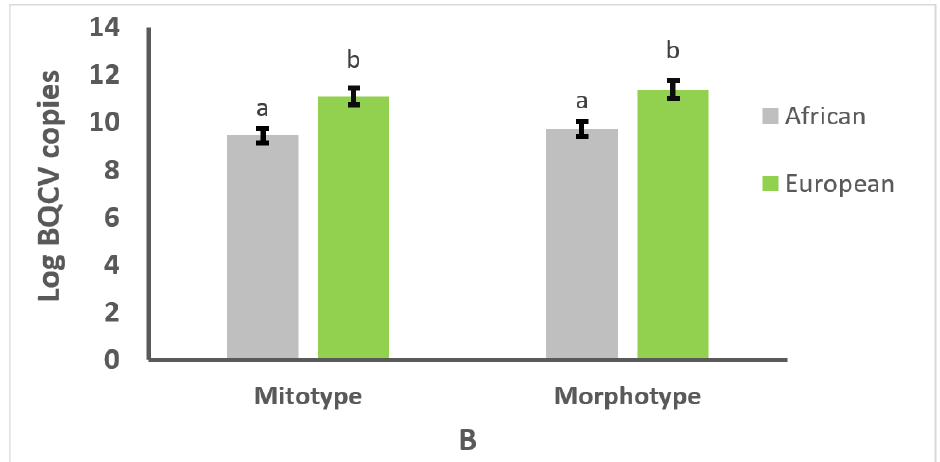
Figure 2. Mean number copies of deformed wing virus (DWV) ( A ) or black queen cell virus (BQCV) ( B )/µg of RNA × 10 6 ± SE in worker honey bees of African and European mitotype and morphotype from 76 colonies. Different letters (a, b) above the bars indicate significant differences between mi- totypes and morphotypes based on Student t tests performed with natural logarithm-transformed data.